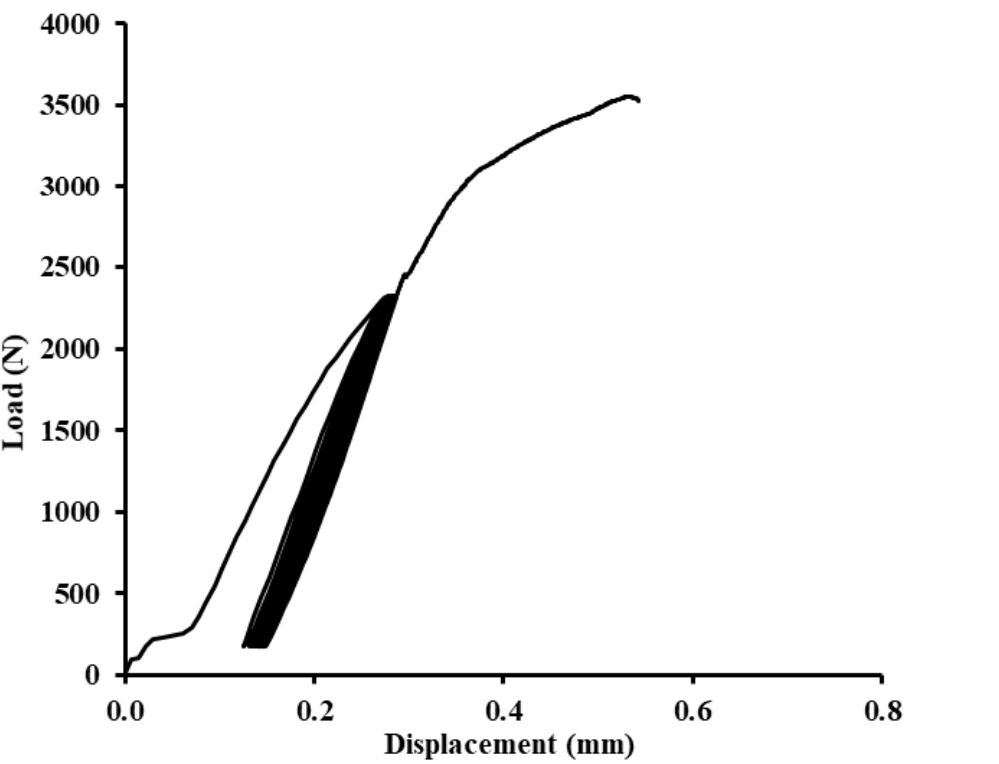
Figure 14. Quasi-static graph of adhesive bond ABFE1 with loading 5–70% (165–2307 N)—1000 cycles.